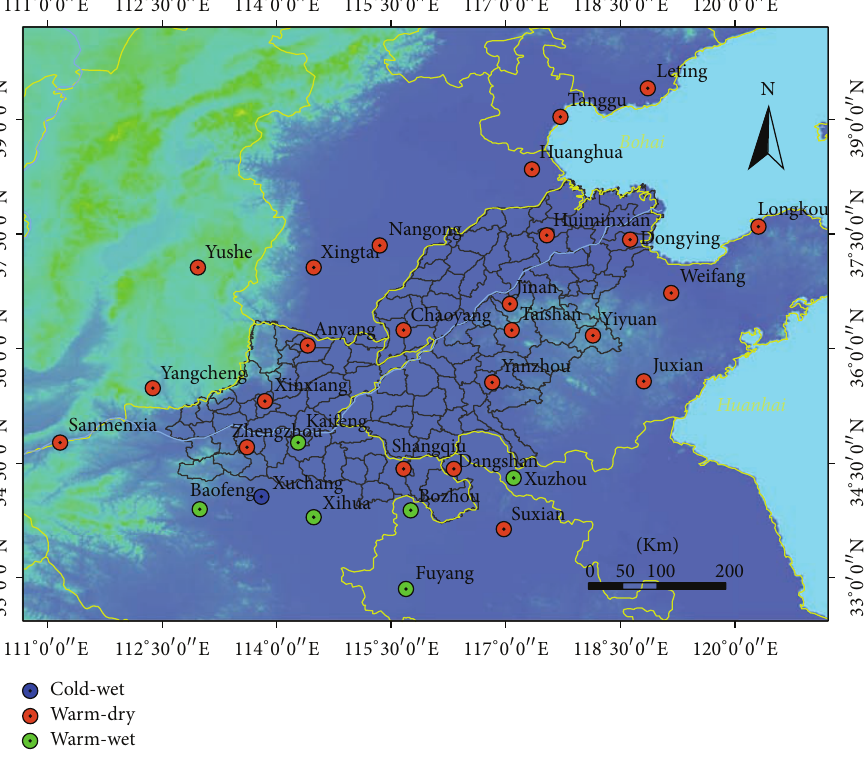
Figure 13: Integrated temperature and precipitation trends at stations in the Lower Yellow River